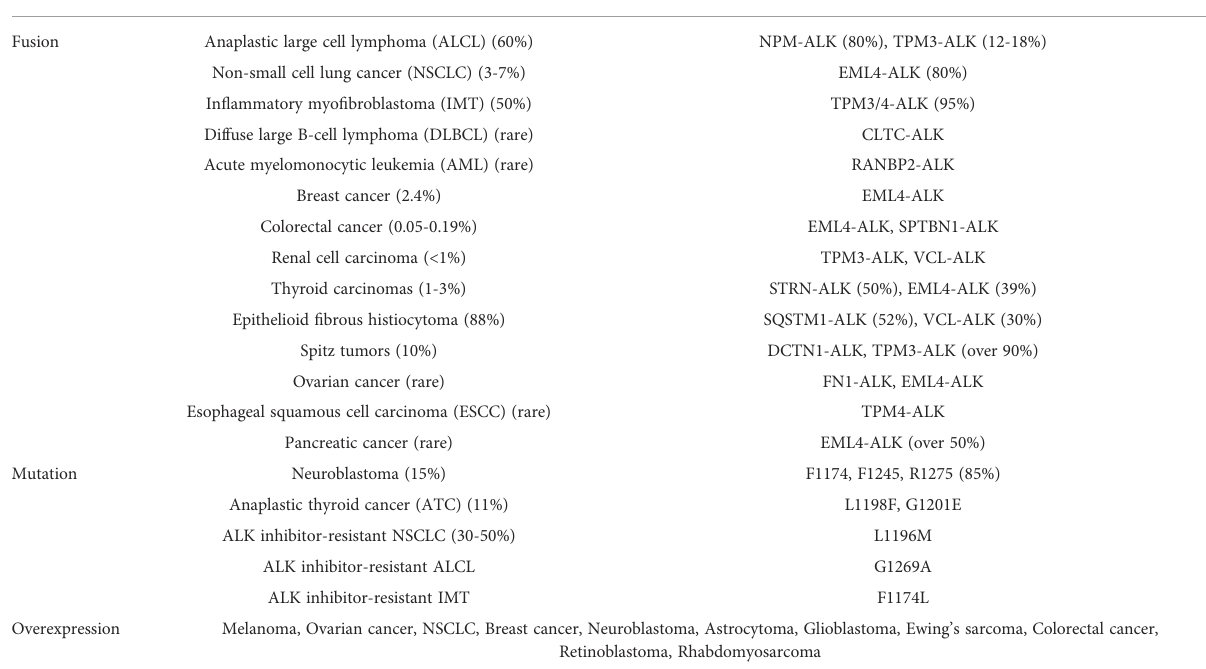
TABLE 1 Summary of ALK